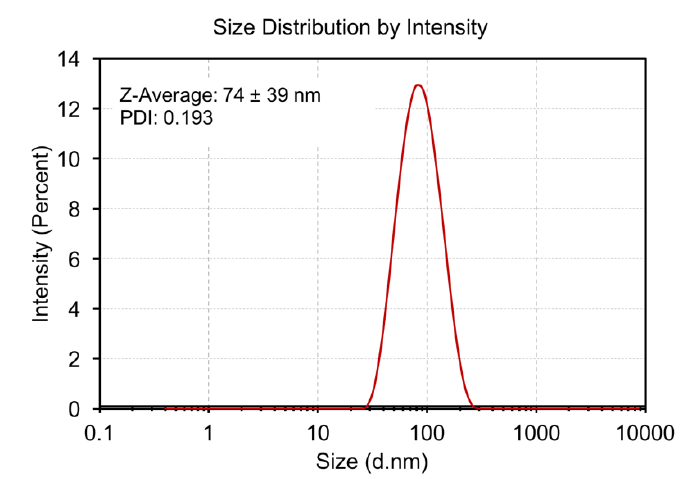
Figure 4. Size distribution of biosynthesized AgNPs by dynamic light scattering (DLS) analysis.